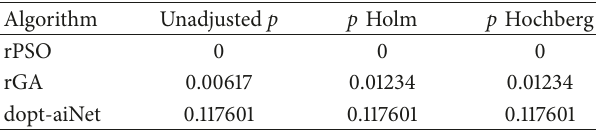
Table 20: Adjusted 𝑝 values associated with PLBA and other com- parable algorithms (Friedman) on dynamic benchmark problems 𝐹